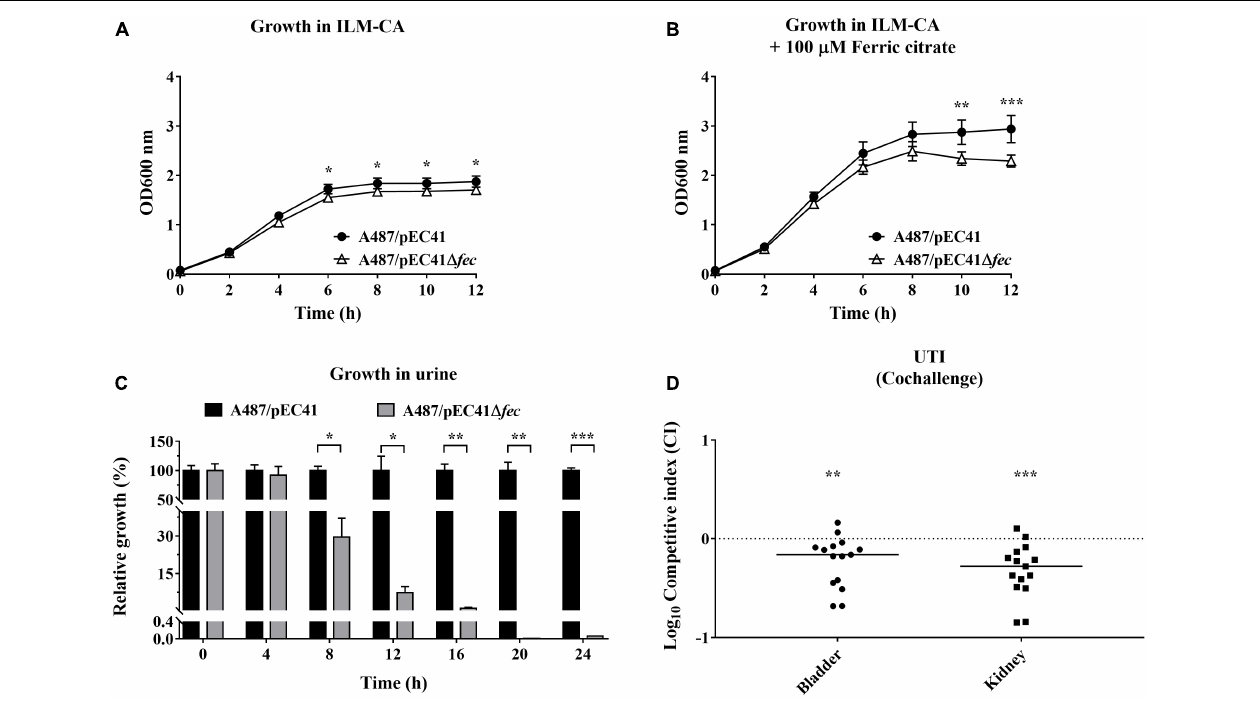
FIGURE 6 | The effect of fec pEC41 on the growth of A487 under iron-limited conditions and in urine and on the ability of the bacteria to colonize urinary tracts. (A) The growth of A487/pEC41 and A487/pEC41 (cid:49) fec cultured in ILM-CA. (B) The growth of A487/pEC41 and A487/pEC41 (cid:49) fec cultured in ILM-CA supplemented with 100 µ M ferric citrate. (C) The growth of A487/pEC41 and A487/pEC41 (cid:49) fec cocultured in urine. The results are shown as the relative growth rates compared to A487/pEC41 at each indicated time point. For (A–C) , the results are presented as the means ± SD. The data are representative of three independent experiments performed in triplicate. (D) Cochallenge of A487/pEC41 and A487/pEC41 (cid:49) fec in a mouse model of UTI. Equal numbers of the two strains were transurethrally coinoculated into female C3H/HeN mice ( N = 15). At 24 h postinfection, the bacterial counts and the CI of A487/pEC41 (cid:49) fec vs. A487/pEC41 in bladders and kidneys were determined. The horizontal bars indicate median values. The dashed line represents the log 10 scale of CI = 1. The two-way ANOVA was used in the statistical analysis of (A,B) . The paired two-tailed student’s t -test was used in the statistical analysis of (C) , while the Wilcoxon signed-rank test was used in (D) . * P < 0.05, ** P < 0.01, *** P <